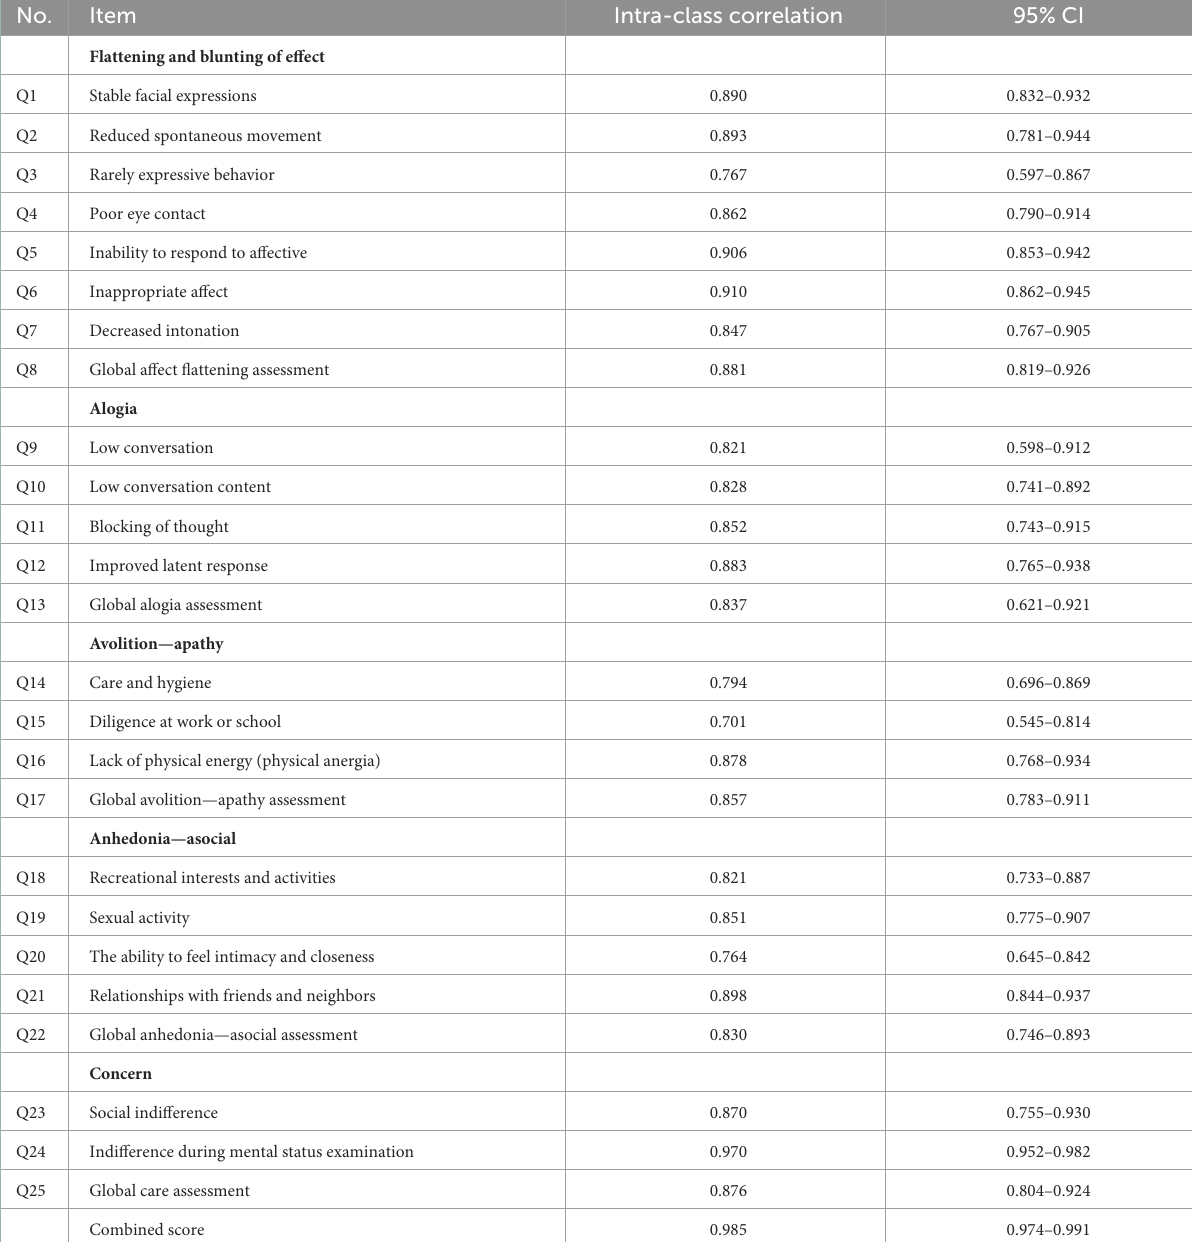
TABLE 6 Inter-rater reliability of Indonesian version of SANS.